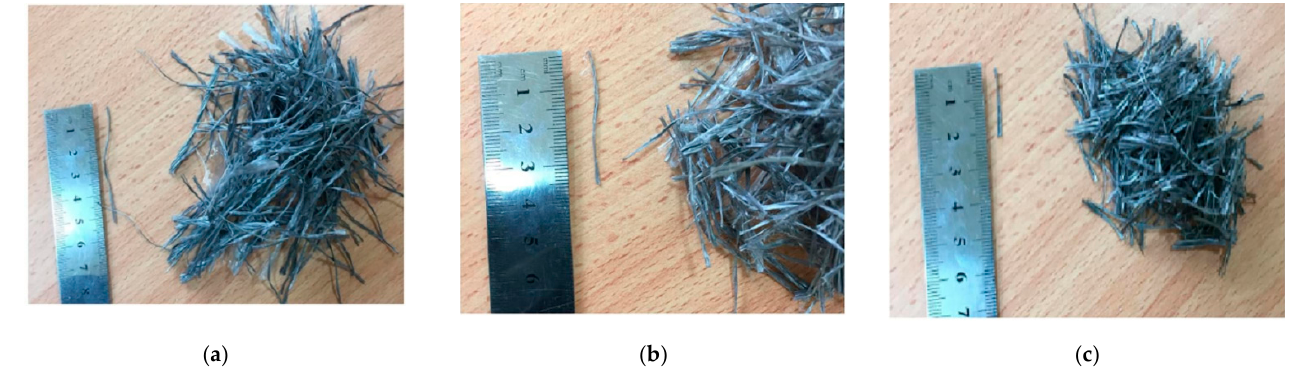
Figure 5. Different lengths of fibres used: ( a ) 57 mm; ( b ) 38 mm; ( c ) 19 mm.